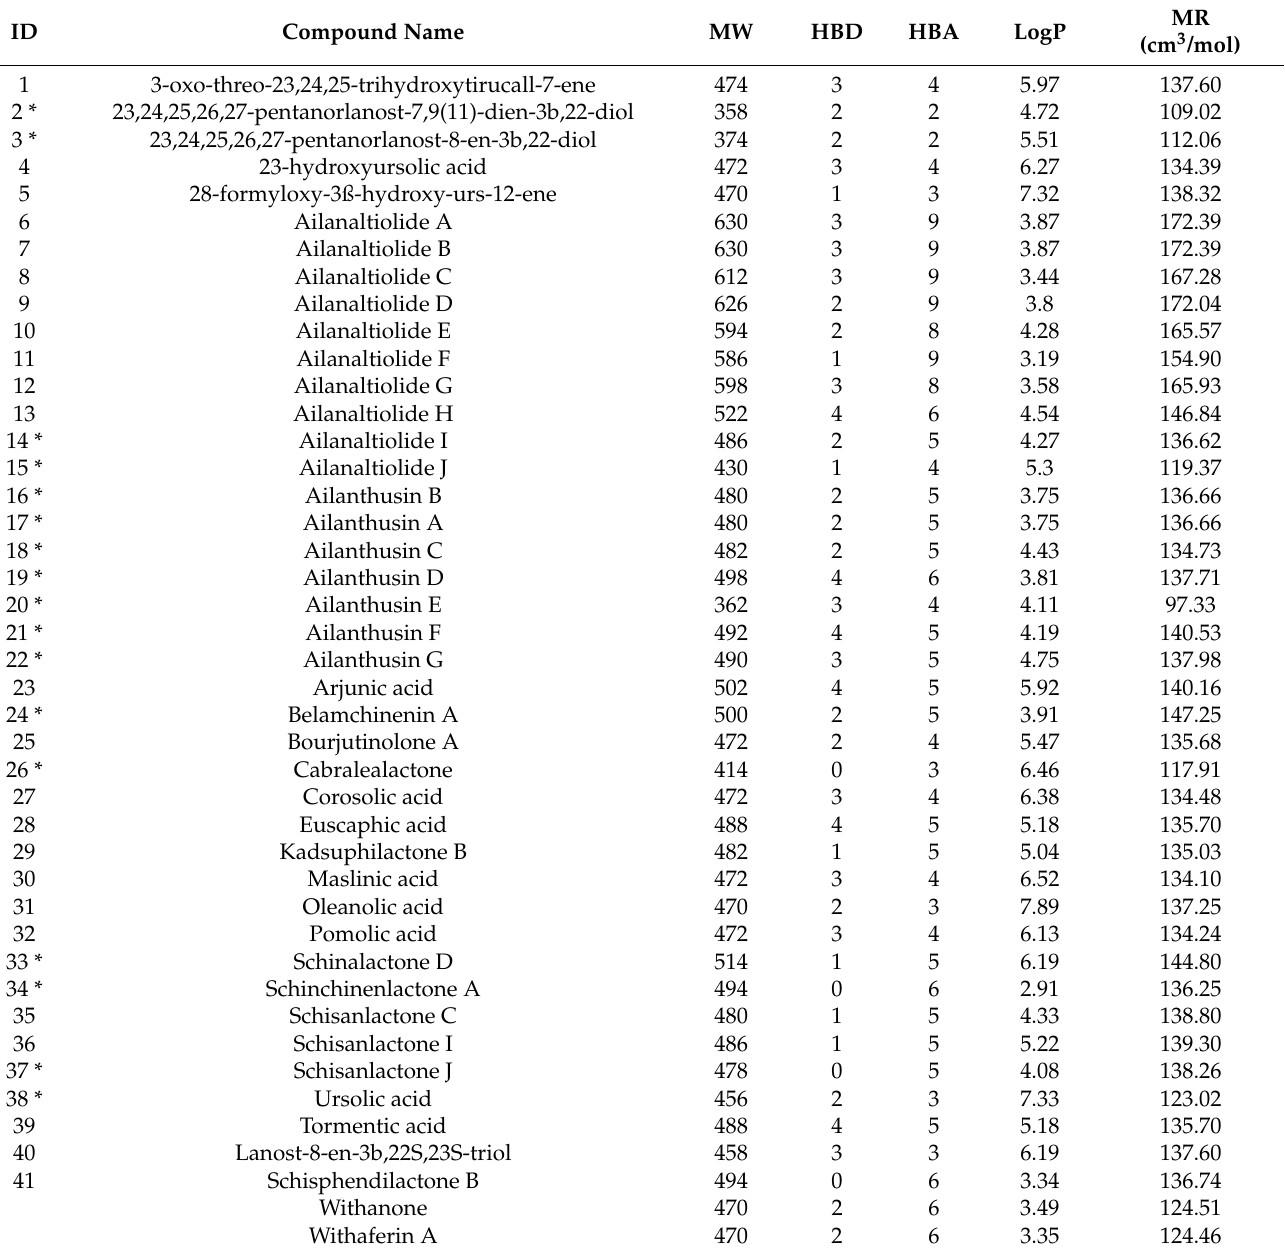
Table 2. Drug-like properties of studied compounds according to Lipinski’s Rule of